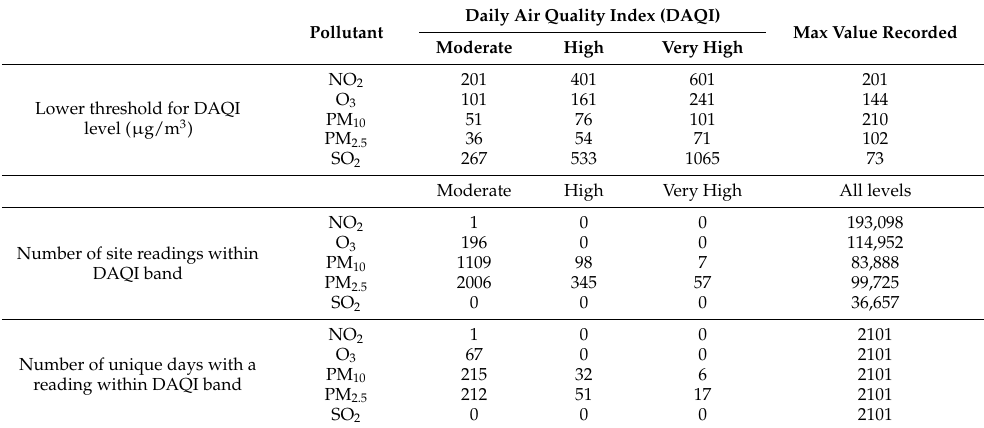
Table 1. Summary of pollutant data illustrating the threshold levels and the number of days when these were exceeded during the study period (1 April 2012–31 December 2017).